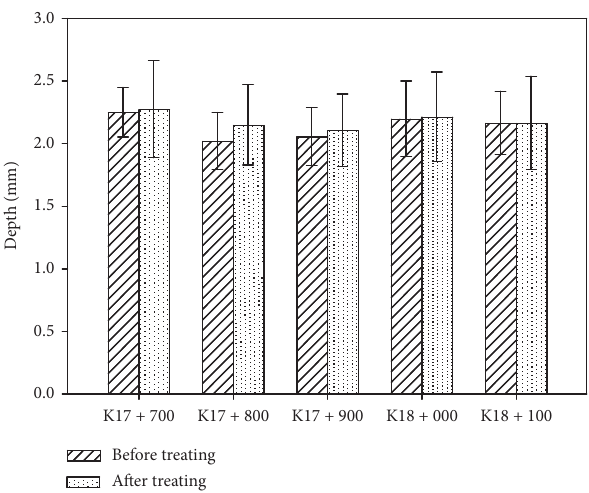
Figure 8: Pavement surface regularities before and after sand fog seal.